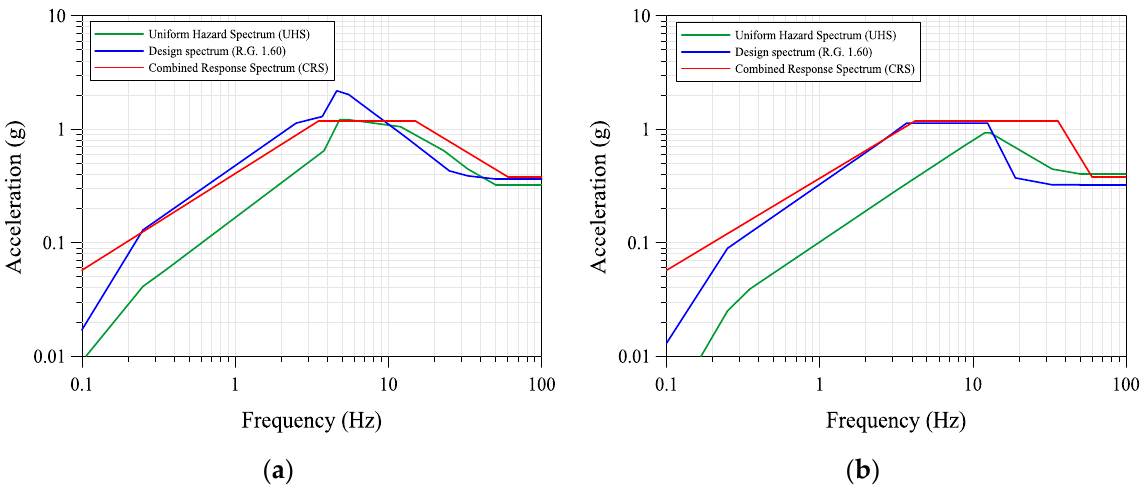
Figure 4. Acceleration comparison for different seismic response spectra: ( a ) side to side and front to back and ( b ) vertical. Table 2. Seismic test sequence.